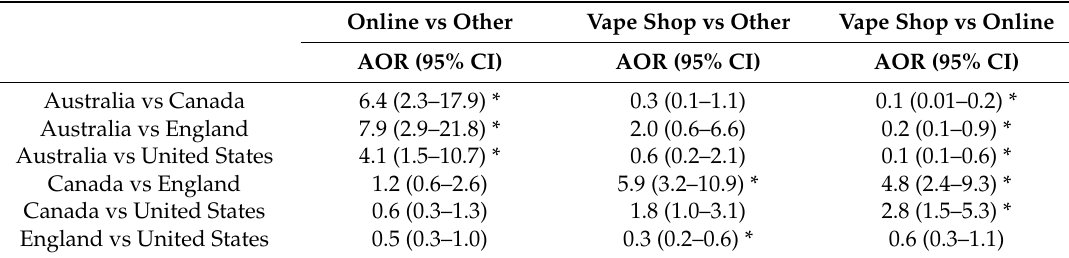
Table 2. Adjusted analyses of purchase location ( n =